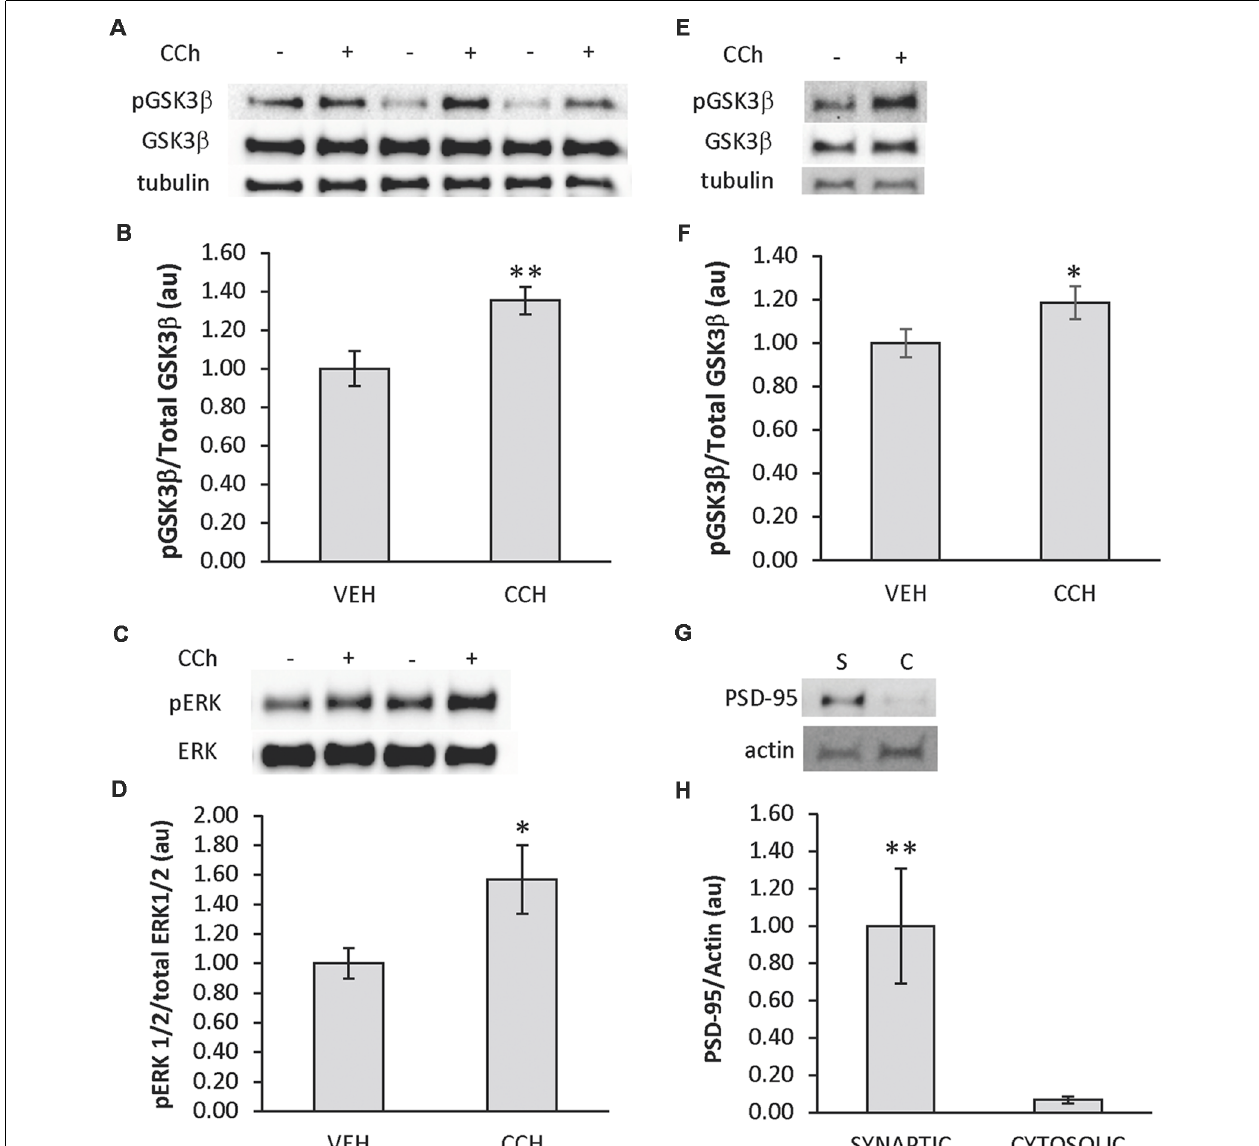
FIGURE 2 | CCh induces phosphorylation of glycogen synthase kinase-3 β (GSK3 β ) and extracellular signal-regulated kinase 1/2 (ERK 1/2) in the telencephalon of adult zebrafish. (A) Representative Western blot of telencephalic tissue from brains incubated in aCSF ± CCh that was probed with pGSK3, GSK3 β and tubulin-specific antibodies. (B) Quantitative analysis of Western blots showing the ratio of pGSK3 β /total GSK3 β increased in the telencephalon when CCh was applied ex vivo ( n = 14 veh; 14 CCh). (C) Representative Western blot of telencephalic tissue from brains incubated in aCSF ± CCh that was probed with pERK, and ERK-specific antibodies. (D) Quantitative analysis of Western blots showing the ratio of pERK/total ERK increased in the telencephalon when CCh was applied ex vivo ( n = 14 veh; 14 CCh). (E) Representative Western blots of the synaptic fraction of telencephalic tissue from brains incubated in aCSF ± CCh that was probed with pGSK3, GSK3 β , and tubulin-specific antibodies. (F) Quantitative analysis of Western blots showing the ratio of pGSK3 β /total GSK3 β increased in synaptic fractions from telencephalon when CCh was applied ex vivo ( n = 11 veh; 11 CCh). (G) Representative Western blot probed with post-synaptic density-95 protein (PSD-95) and actin-specific antibodies confirming PSD-95 in synaptic (S) vs. cytosolic (C) fractions. (H) Quantitative analysis of Western blots showing the enrichment of PSD-95 in synaptic fractions (n = 7 synaptic; 7 cytosolic). In plots, values presented as mean ± SE, arbitrary units. Control set at 1.0. ∗ P < 0.05; ∗∗ P < 0.01 ( t